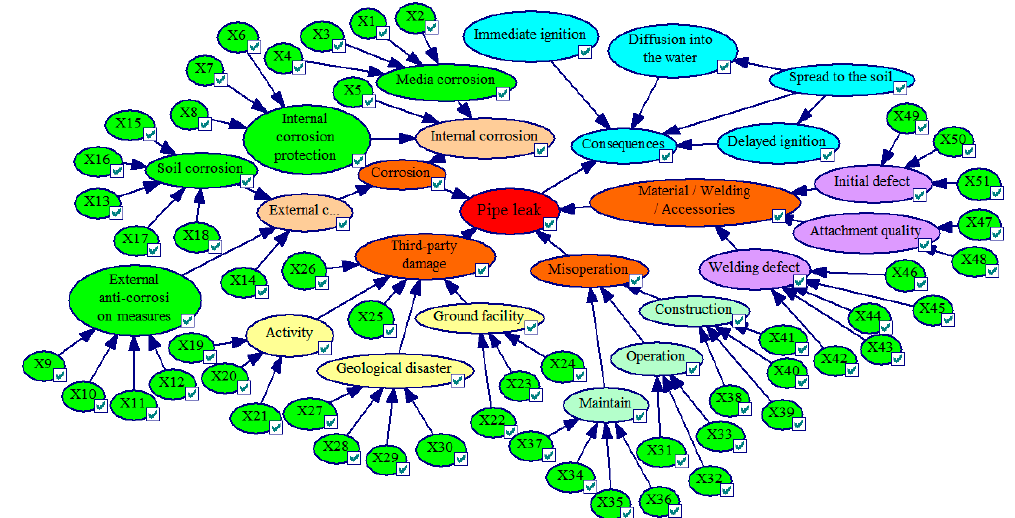
Figure 8. The BN of safety evaluation of heavy oil gathering pipelines.